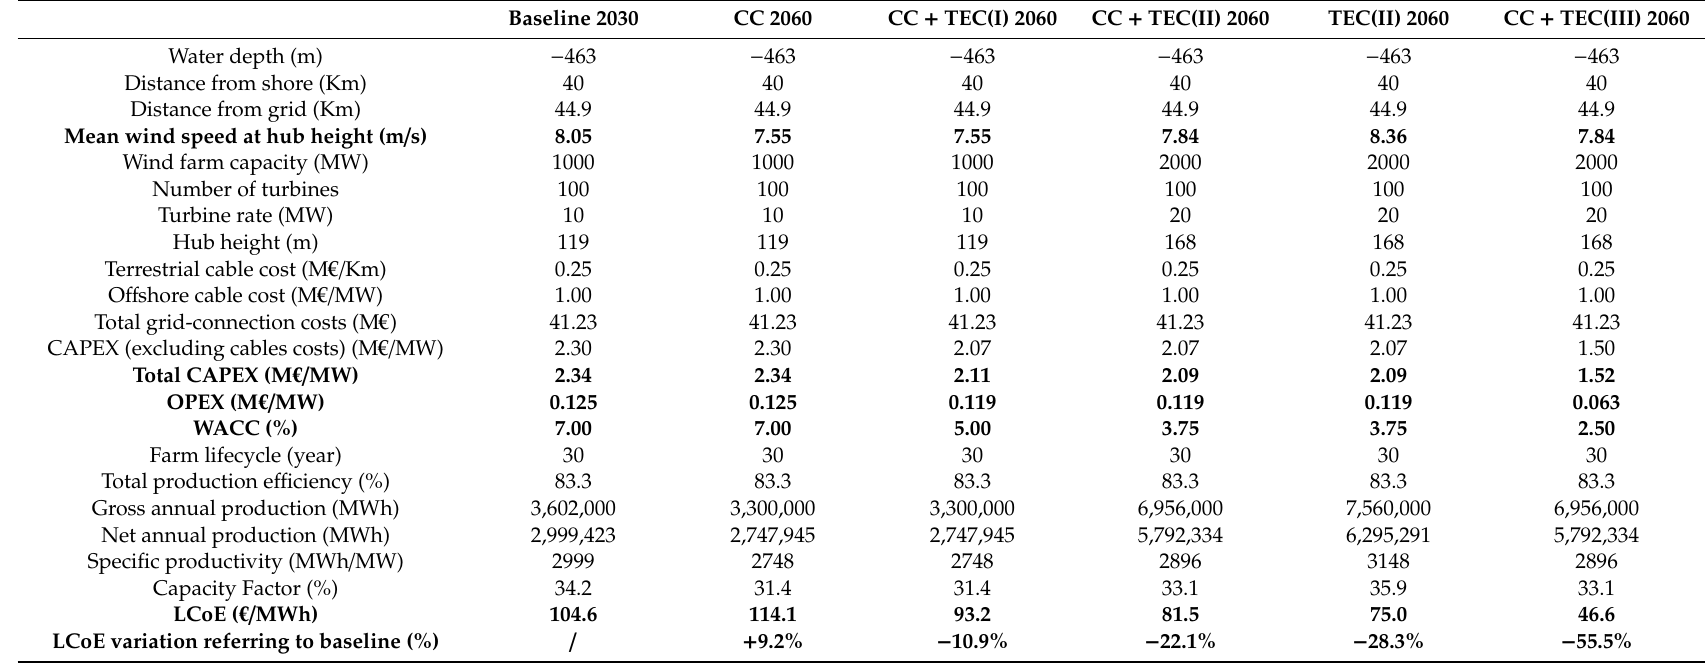
Table 7. Case study 2 (Sicily); net wind speed variation: − 0.50 m / s. (Variable parameters in